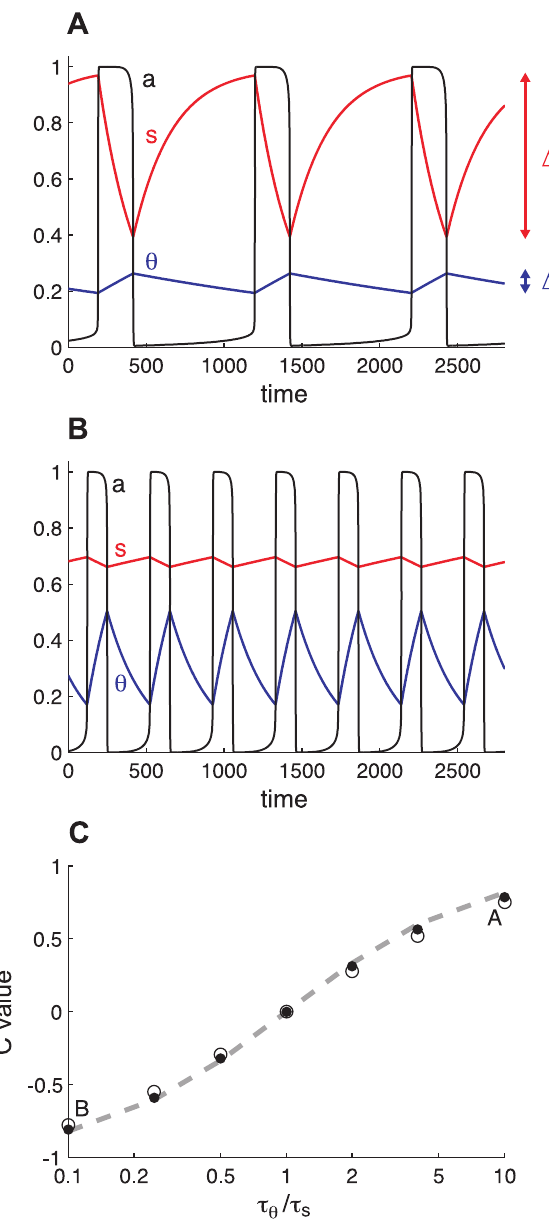
Figure 1. Illustration of the concept that the faster process contributes more to rhythm generation. A. Time courses of activity ( a , black), the synaptic recovery variable ( s , red), and the adaptation variable ( h , blue) for t h / t s =10. The range of variation of s ( D s ) is about 10 times larger than the range of variation of h ( Dh ). Thus, according to the correlative measure s contributes more to the rhythmicity. B. Similar time courses for t h / t s =0.1. The cellular adaptation now appears to contribute more than the synaptic recovery variable. C. Plot of the variations of C= (R 2 1)/(R + 1) with the t h / t s ratio. Closed circles obtained from simulations with h 0 =0; open circles for h 0 =0.18. When h is much faster than s ( t h / t s is small), C is close to -1 indicating that h is the dominant process. When t h < t s , C < 0 indicating that both processes have equal contribution to the rhythm. At large t h / t s , C approaches 1 and s is the dominant process. Points labeled A and B refer to the cases illustrated in panels A and B. Dashed curve, variations of c=(r 2 1)/(r + 1) with t h / t s ; r=(w/g)( t h / t s ) and w=g=1. Results are similar if we keep t h / t s =1 and vary w/g